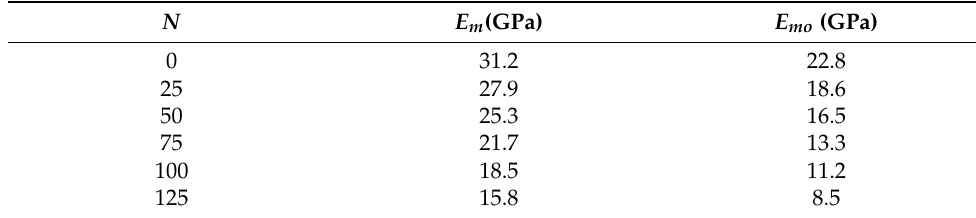
Table 2. The elastic modulus of concrete and mortar.